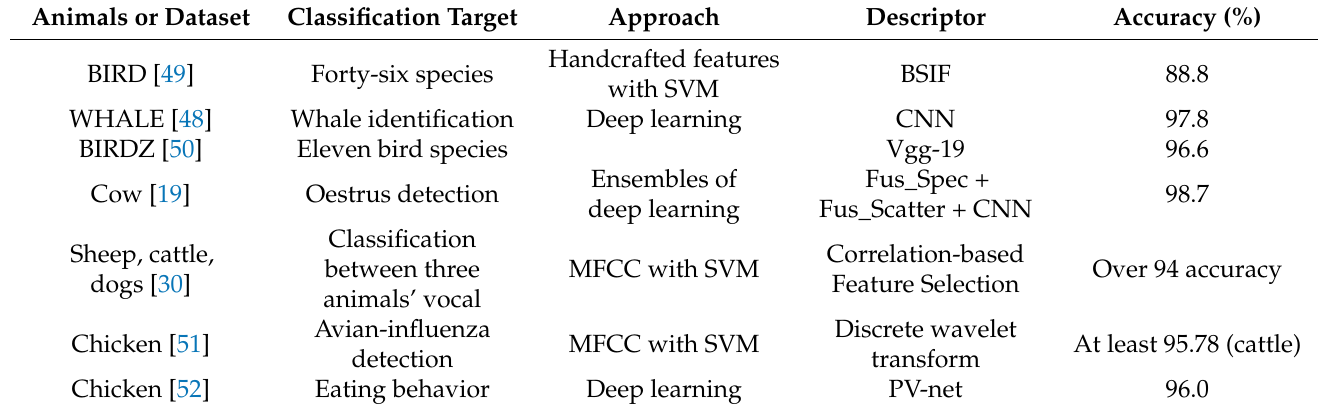
Table 4. Summary of prediction accuracies of animal sound classification.